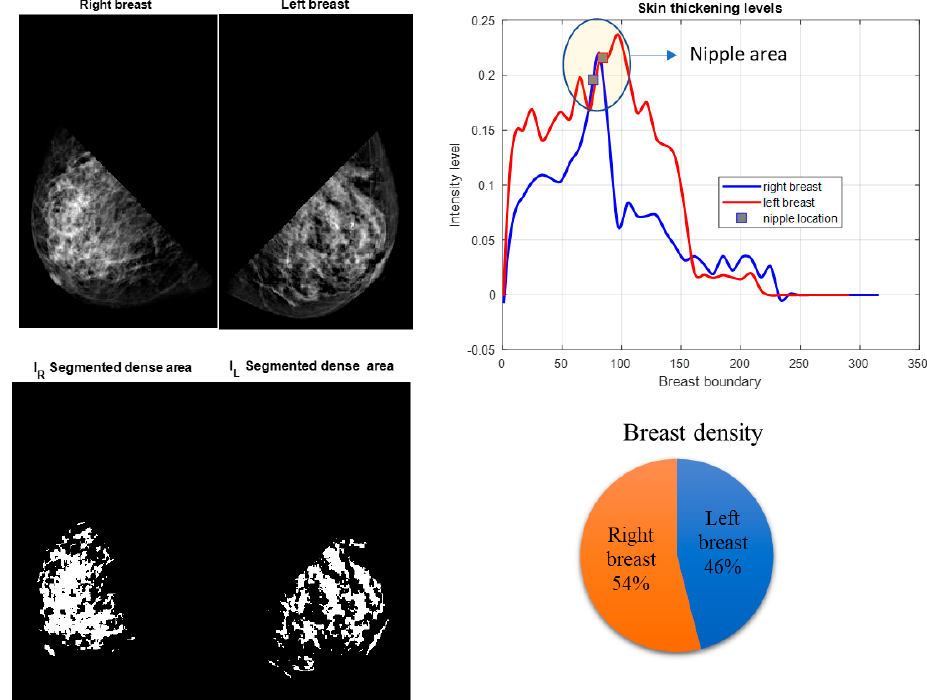
Figure 4. Non-IBC breast cancer patient. MLO view. The lower quadrants of the right and left breast are segmented. Breast density in both breasts is measured. The right and left breast skin thickening and density are calculated as average intensity values and compared. Both breasts showed comparable breast thickening and density measurements.